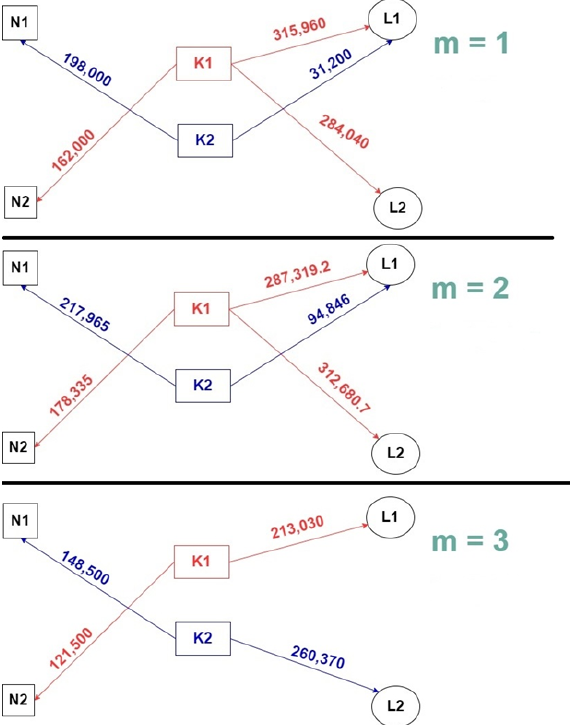
Figure 3. Optimal network diagram representation of the quantity distribution